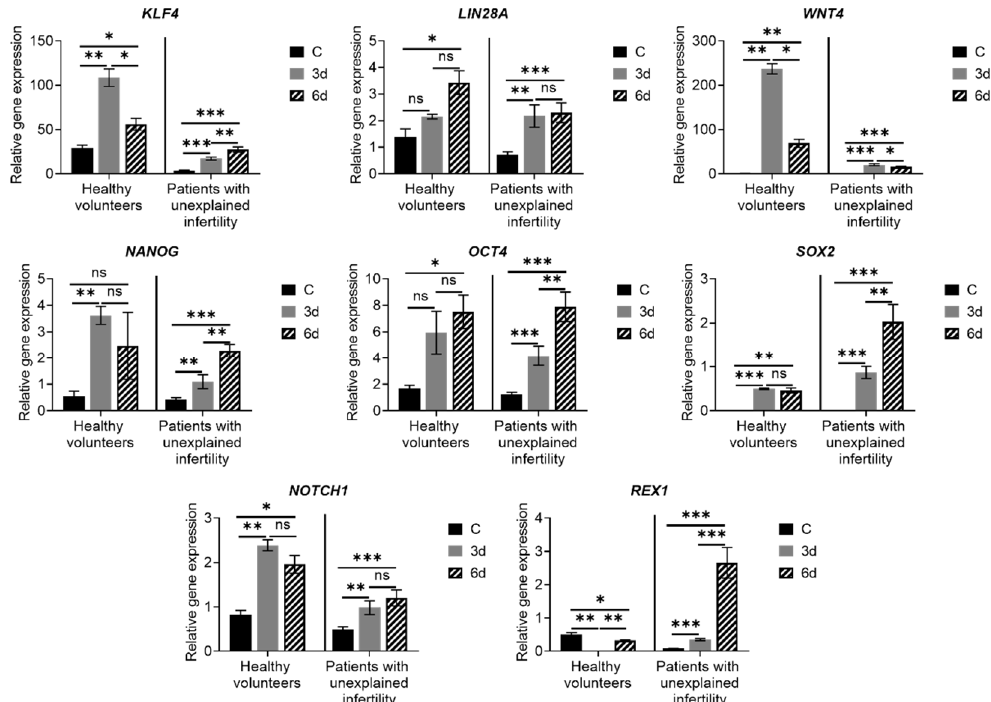
Figure 5. Expression of stemness genes inherent in decidualization. Results are presented as mean ± standard deviation. In the group of healthy volunteers n = 2, in patients with unexplained infertility n = 4. C—control cells, 3d—cells after 3 days of culture in decidualization medium, 6d—cells after 6 days in differentiation medium. * p ≤ 0.05; ** p ≤ 0.01; *** p ≤ 0.001, ns—not statistically significant, based on t -test (Holm–Sidak